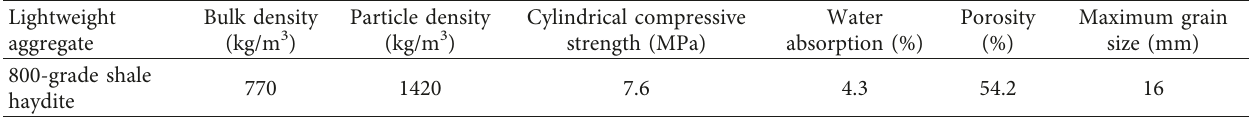
Table 1: Main properties of lightweight aggregates.